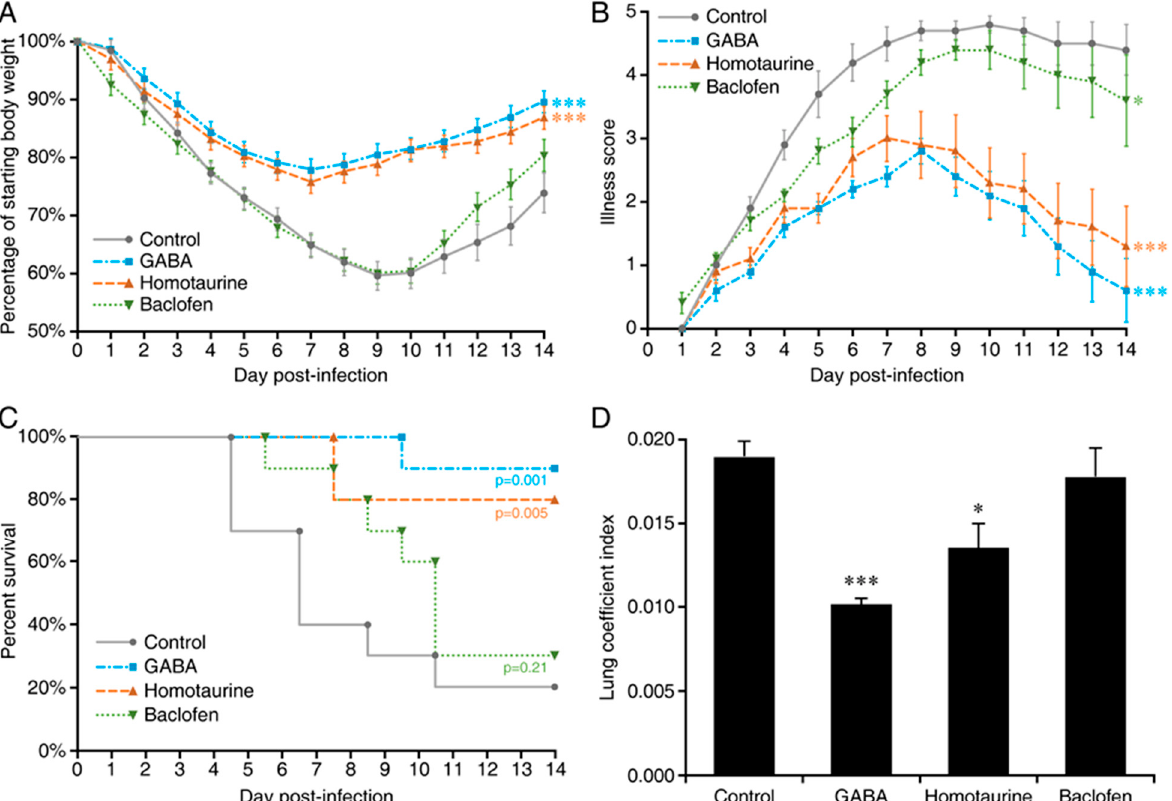
Figure 3. Effect of GABAA-R vs. GABAB-R agonists in MHV-1-infected mice. Mice were inoculated with MHV-1 (5 × 10 3 PFU) and immediately given plain drinking water, or water containing GABA (2 mg/mL), homotaurine or baclofen. The average daily water consumption per mouse in each group is shown in Supplemental Figure S8: ( A ) Daily changes in mean % ± SEM of body weights post-infection (% of day 0), *** p < 0.001 vs. control, computed by a RM ANOVA model; ( B ) Daily scores for the severity of their illness. The data shown are the mean illness scores ± SEM for each group. p values are indicated for each treatment vs. the control as calculated by the Kruskal–Wallis test. * p < 0.05, *** p < 0.001; ( C ) Daily percent of surviving mice in each group. Indicated p values vs. the control were calculated by the log-rank test; ( D ) Lung coefficient indexes. The lungs were harvested and weighed when an animal became moribund or at 14 days post-infection. The data shown are the mean lung coefficient index ± SEM for each group. * p < 0.05, *** p < 0.001 vs. the control water treated group by Student’s t -test. For all studies, n = 10 mice/group from two separate